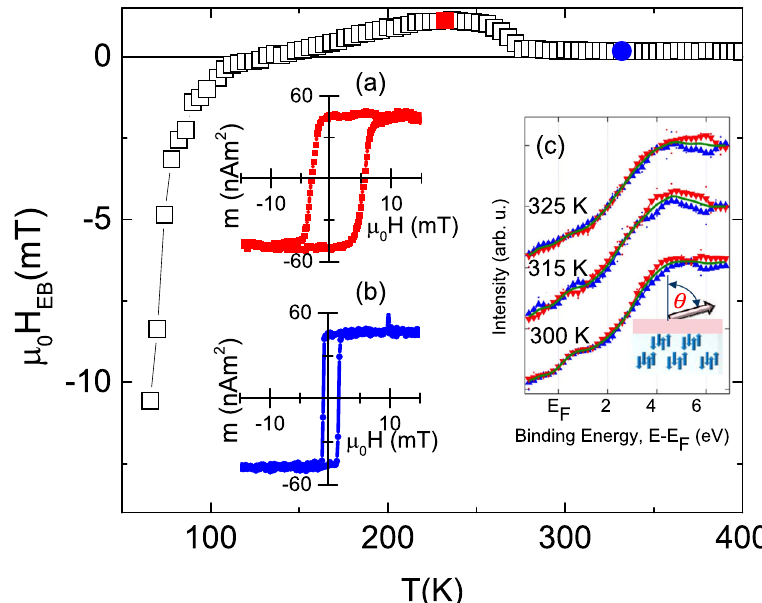
Fig. 1 Spectroscopy and magnetometry of B-doped chromia fi lms and their heterostructures. EB fi eld μ 0 H EB versus T (open squares in main panel) for heterolayer based on B-doped chromia and in-plane anisotropic CoPd top layer. Insets a (red squares) and b (blue circles) show representative hysteresis loops at 323 and 232 K. The loops are associated with μ 0 H EB versus T data highlighted by solid symbols. Inset c shows spin-resolved inverse photoemission data for the surface of a B-doped chromia thin fi lm at 300, 315, and 325 K. The inset shows a cartoon of the fi lm with spin structure (tilt not shown) and boundary magnetization tilted by the angle θ relative to the c -axis (surface